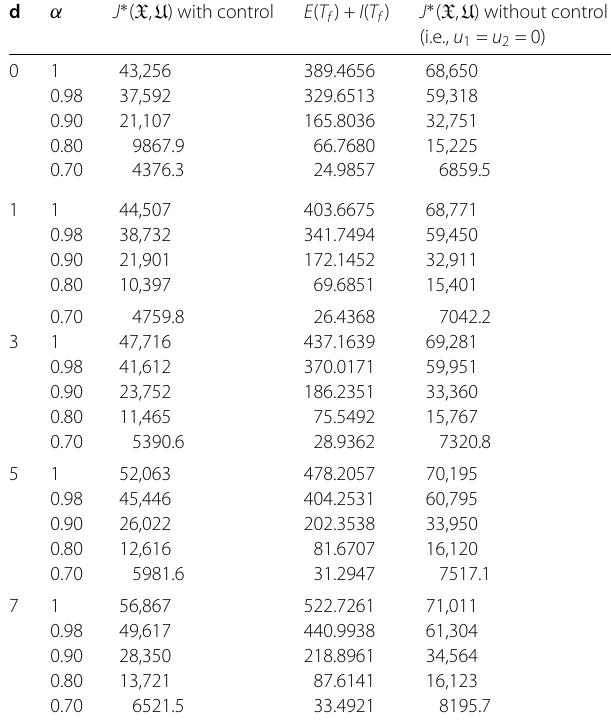
Table 4 Comparisons between the value of objective function J ∗ ( X , U ) with and without control cases and E ( T f ) + I ( T f ) when 0 ≤ u 1 ≤ 0.8, 0 ≤ u 2 ≤ 0.5, at different time delay d and different α with